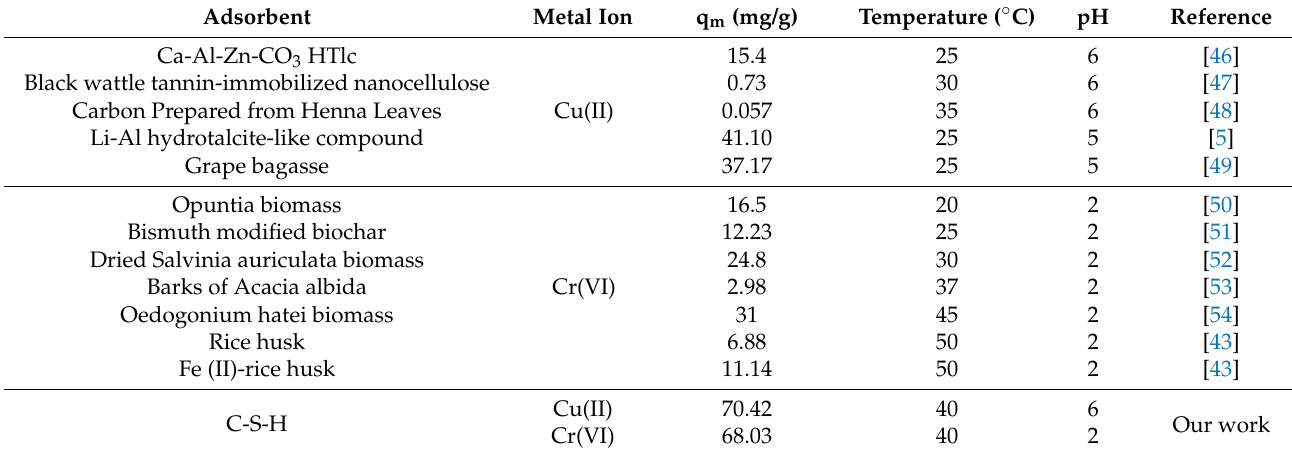
Table 2. Comparison of Cr(VI) and Cu(II) adsorption results of C-S-H with other adsorbents.